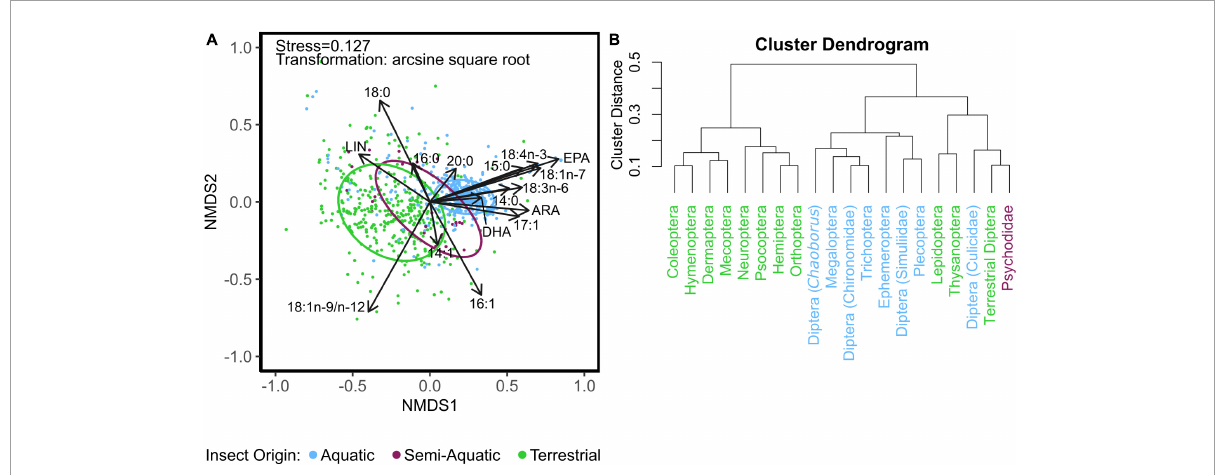
FIGURE2 (A) Non-metric multidimensional scaling (NMDS) of arcsine-square-root-transformed fatty acid fractions (% of total fatty acids) of aquatic, semi-aquatic, and terrestrial insects. Vectors represent fatty acids that had a significant regression value ( p < 0.001) and a vector length of 0.33 or greater. Ellipses represent 75% confidence intervals. (B) Hierarchal cluster analysis of mean fatty acid content (mg mg − 1 DW). Fatty abbreviations: linoleic acid (LIN; 18:2n-6), arachidonic acid (ARA; 20:4n-6), eicosapentaenoic acid (EPA; 20:5n-3), and docosahexaenoic acid (DHA;